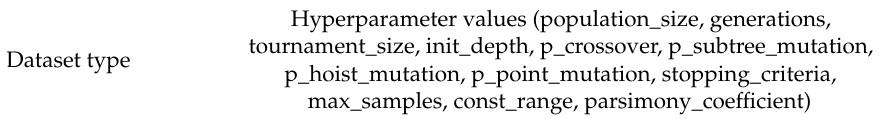
Table 10. GPSC hyperparameters used to obtain best symbolic expressions in terms of high classifica- tion